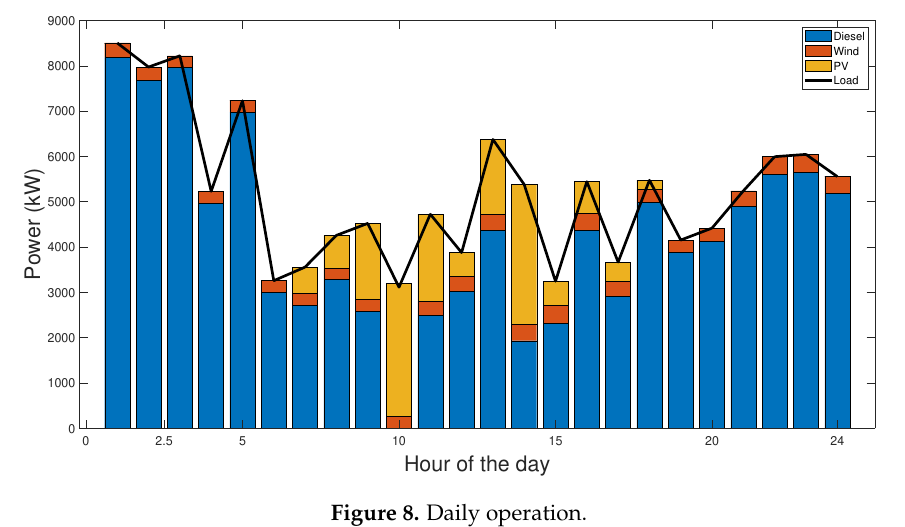
Figure 8. Daily operation.